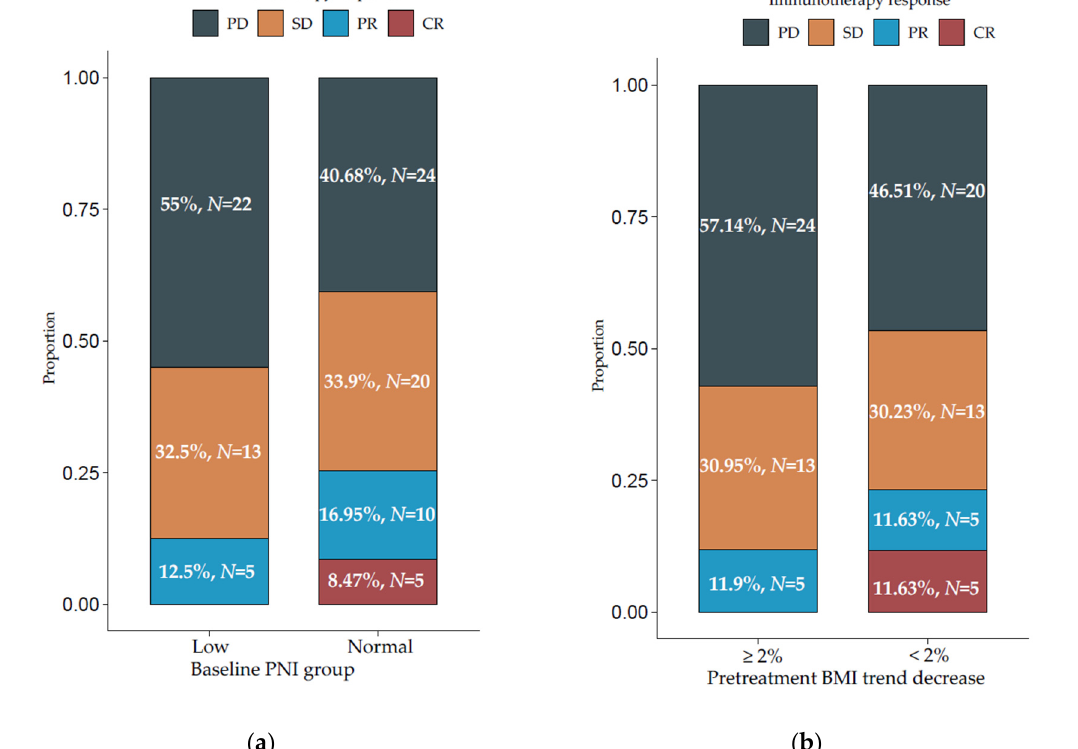
Figure 3. Percentages of immunotherapy responses in patients with ( a ) low vs. normal baseline prognostic nutritional index (PNI) and ( b ) pretreatment BMI trend decrease ≥ 2% vs. <2%. CR—complete response; PR—partial response; SD—stable disease; PD—progressive disease.